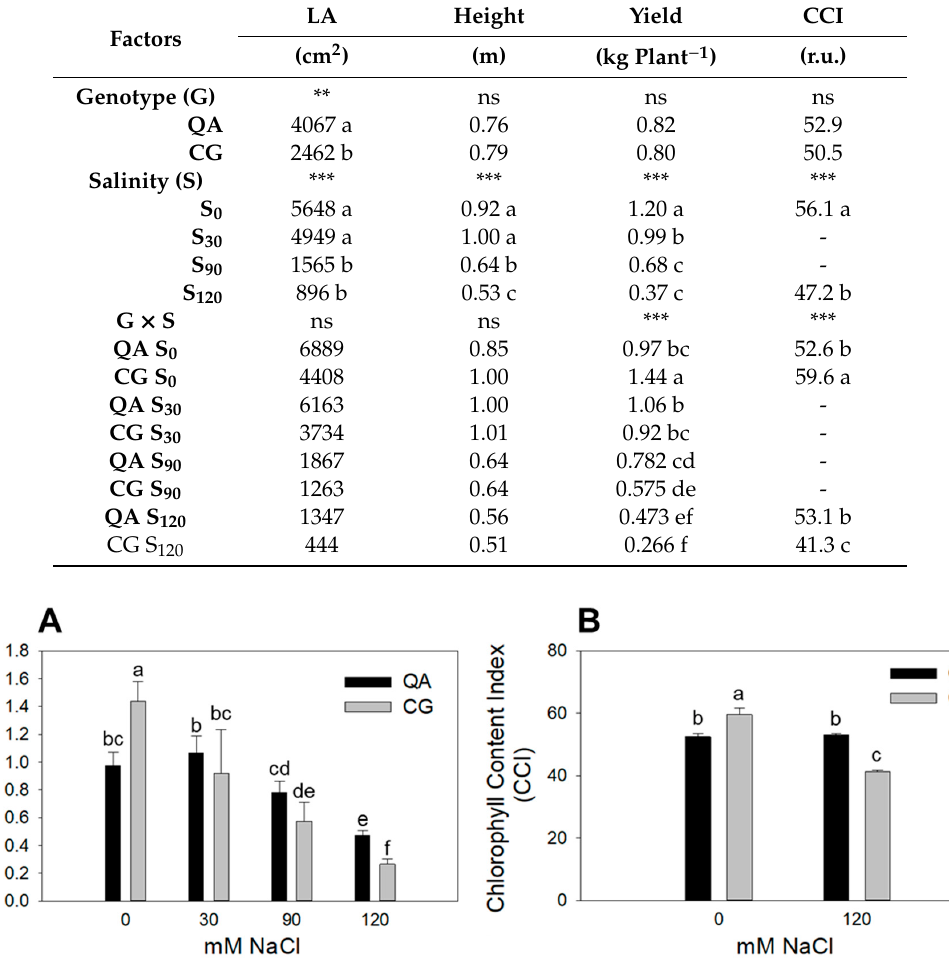
Figure 1. ( A ) Yield (kg plant − 1 , DAT 168) and ( B ) CCI (DAT 65) of the commercial cultivar (QA) and the landrace (CG) grown at control (0 mM), low salinity (30 mM), moderate salinity (90 mM) and high salinity (120 mM) for yield, and at control (0 mM) and high salinity (120 mM) for CCI. Error bars indicate standard error of the means. Means with the same letter are not significantly different according to Duncan’s post hoc test ( p < 0.05).